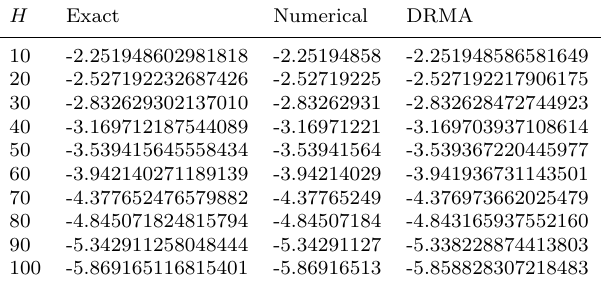
Comparison between the exact, numerical results [1] and DRMA solutions for γ = f (cid:48)(cid:48) (0) for different values of Hartmann numbers when α = 5 0 and Re = 10 .